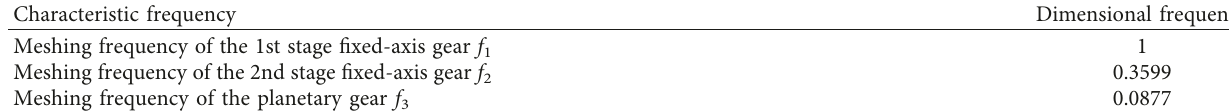
Table 2: Dimensionless characteristic frequencies of the multistage gear transmission system (Hz).